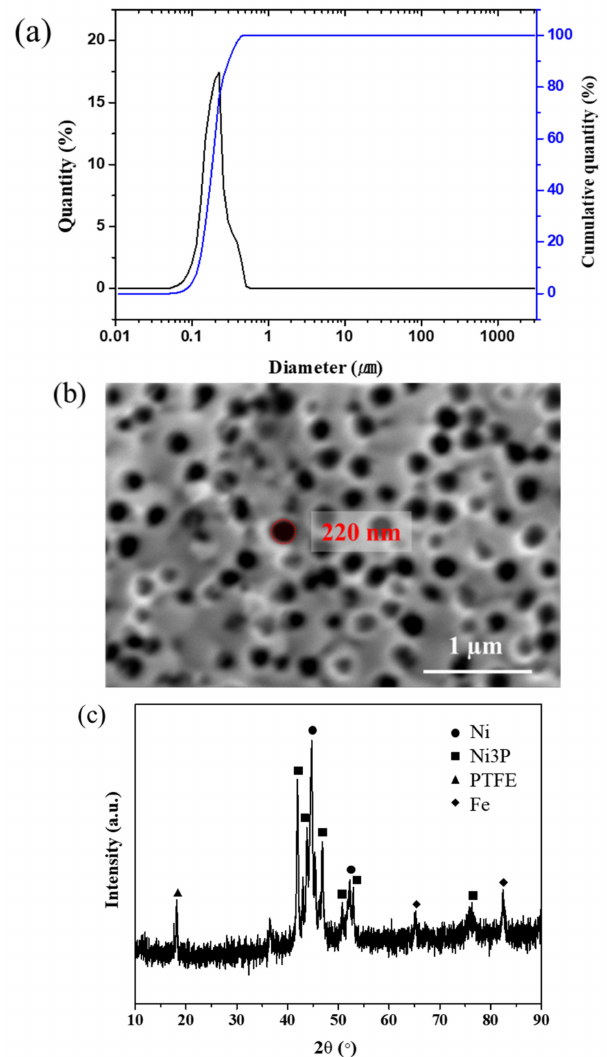
Figure 2. ( a ) Laser diffraction particle size analysis of the PTFE particles; ( b ) SEM image; and ( c ) XRD pattern of the Ni-P-PTFE plating